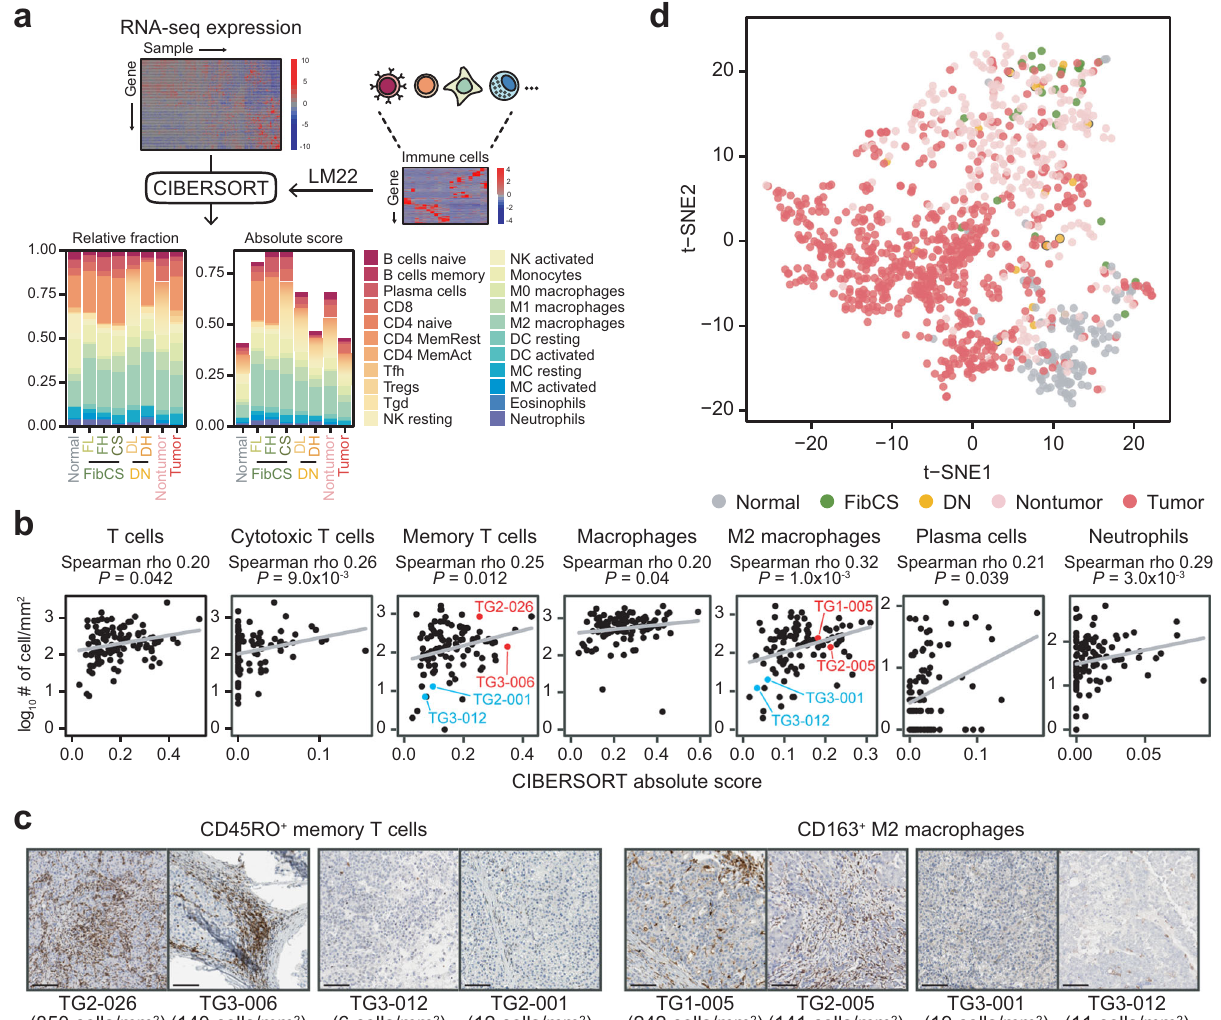
Fig. 2 Deconvolution of immune cells and validation with IHC-derived cell counts. a Schematic work fl ow of deconvolution using CIBERSORT. b Spearman correlations between CIBERSORT absolute score ( X -axis) and IHC cell count ( Y -axis). c Representative samples highly in fi ltrated with or lacking (marked as red or blue in b , respectively) memory T cells or M2 macrophages in tumor tissue. The average number of cells are shown on a scale with units of cells/mm 2 . Scale bars: 100 µm. d t-SNE analysis of the integrated dataset based on CIBERSORT absolute scores. Samples are color-coded by disease